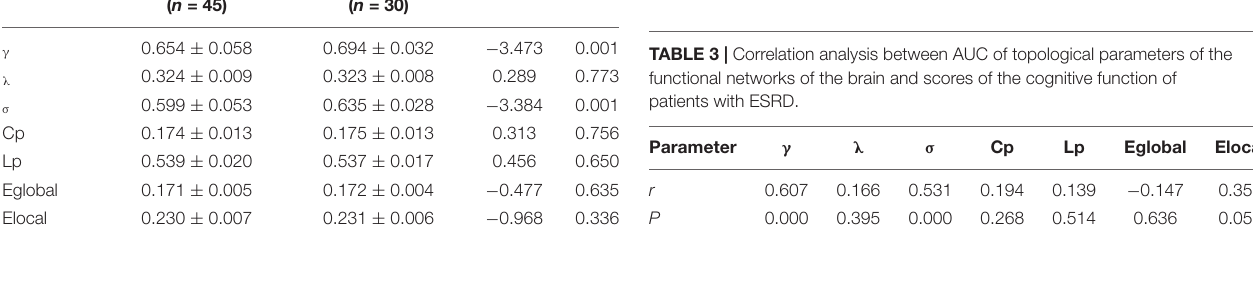
TABLE 2 | AUC of topological parameters of the functional networks of the brain between patients with ESRD and normal controls ( ¯ x ± s ). Parameter ESRD patients ( n = 45)